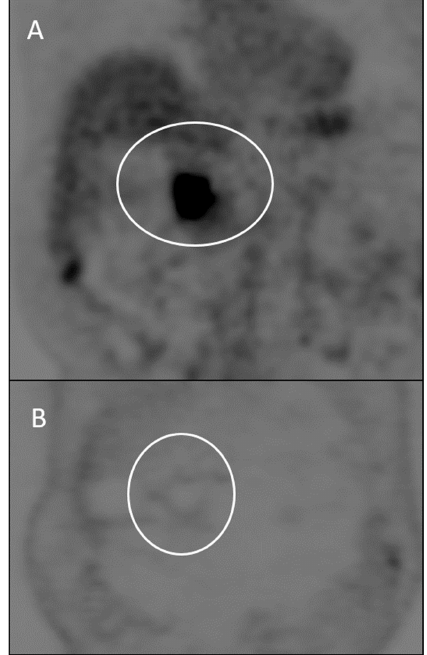
Figure 2. PET/CT images obtained before ( A ) and after ( B ) ECT treatment of locally advanced pan- creatic carcinoma. Note complete decline in SUL. This decline represents metabolic complete re- sponse by PERCIST.